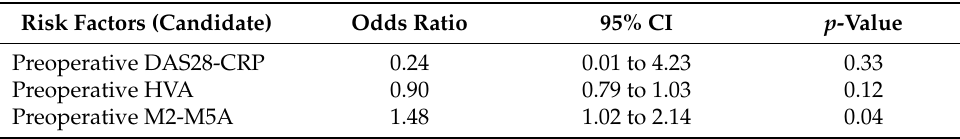
Table 7. Risk factors for resubluxation of the lesser-toe MTP